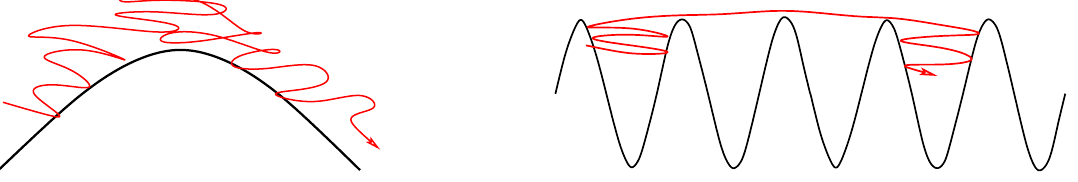
Figure 3 . Cartoon illustrating the dynamical prefactor d . For extremely strong damping (left), the trajectory can cross the barrier several times in succession, leading to only one (or zero) true crossings. For underdamping (right), it can cross several barriers in